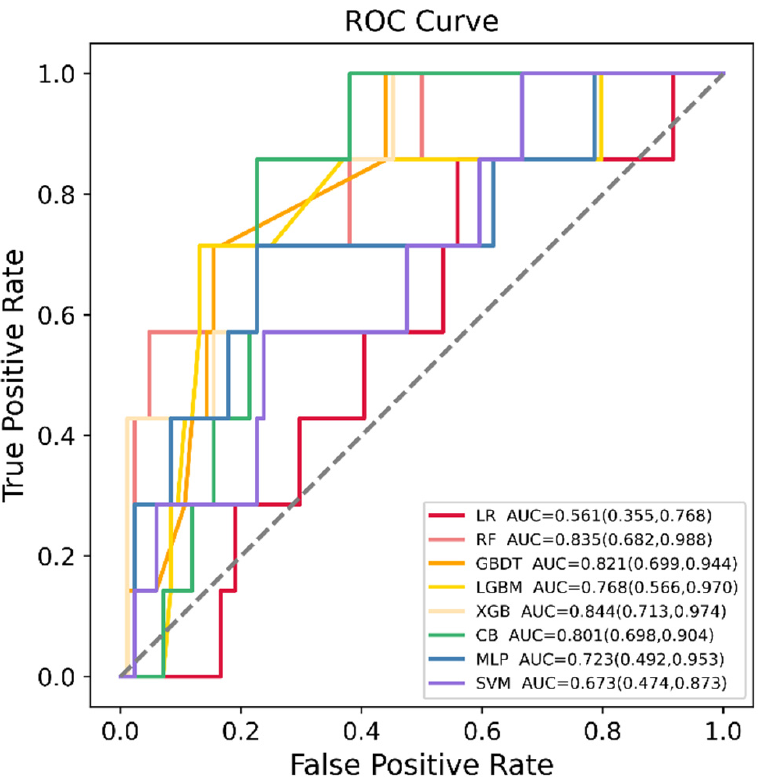
Figure 2. Receiver operating characteristic (ROC) curves of the eight machine learning (ML) models in predicting small for gestational age (SGA) in the testing dataset. LR = logistic regression, RF = random forest, GBDT = gradient boosting decision tree, LGBM = light gradient boosting machine, XGB = extreme gradient boosting, CB = category boosting, MLP = multi-layer perceptron, SVM = support vector machine. Table 2. Performance of models by different algorithms in predicting small for gestational age (SGA) neonates.